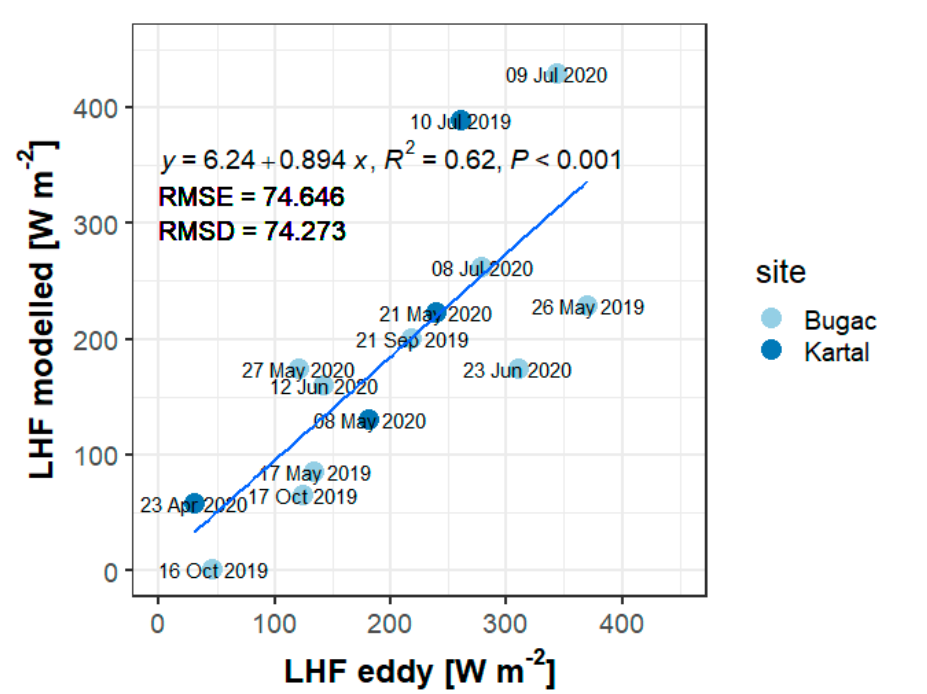
Figure 6. Comparison of modelled (pyTSEB based on thermal orthomosaic produced from UAV flight) and measured (eddy covariance) latent heat fluxes from a grassland (Bugac) and from a cropland (Kartal). UAV flights were performed during 2019–2020.